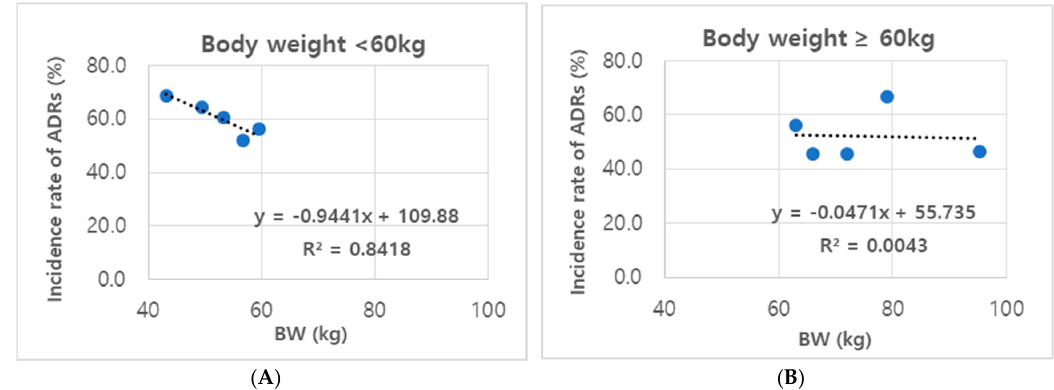
Figure 2. ADR incidence rates in subgroups tiered by BW. ( A ) Male and female patients with a BW < 60.0 kg and ( B ) Male and female patients with a BW ≥ 60.0 kg.